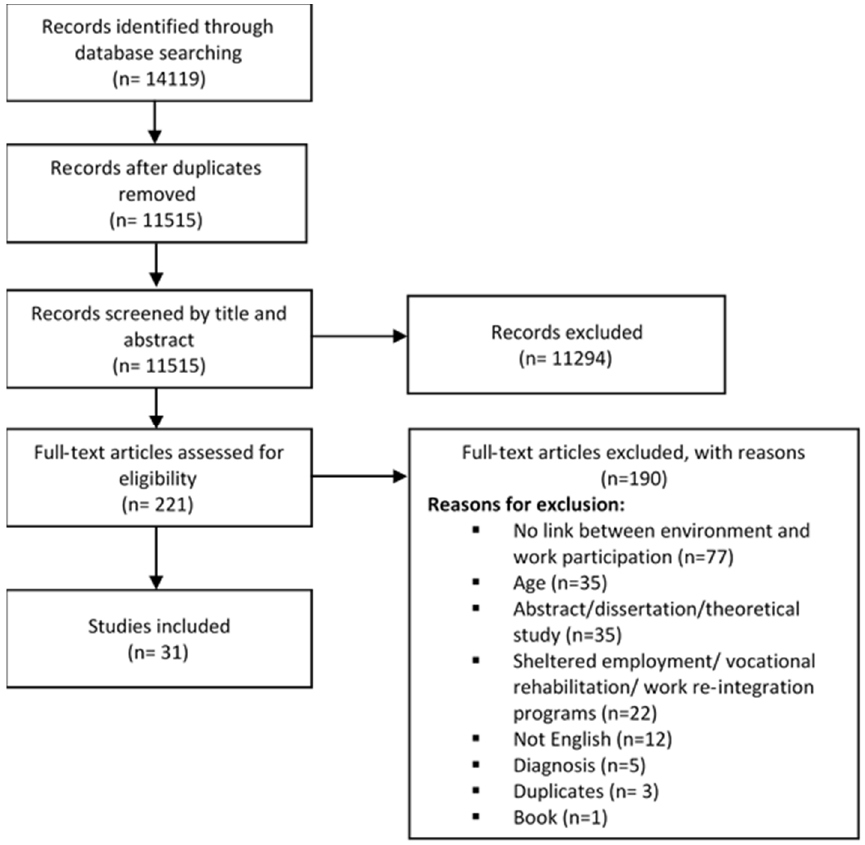
Figure 1. Flow chart of study selection process.